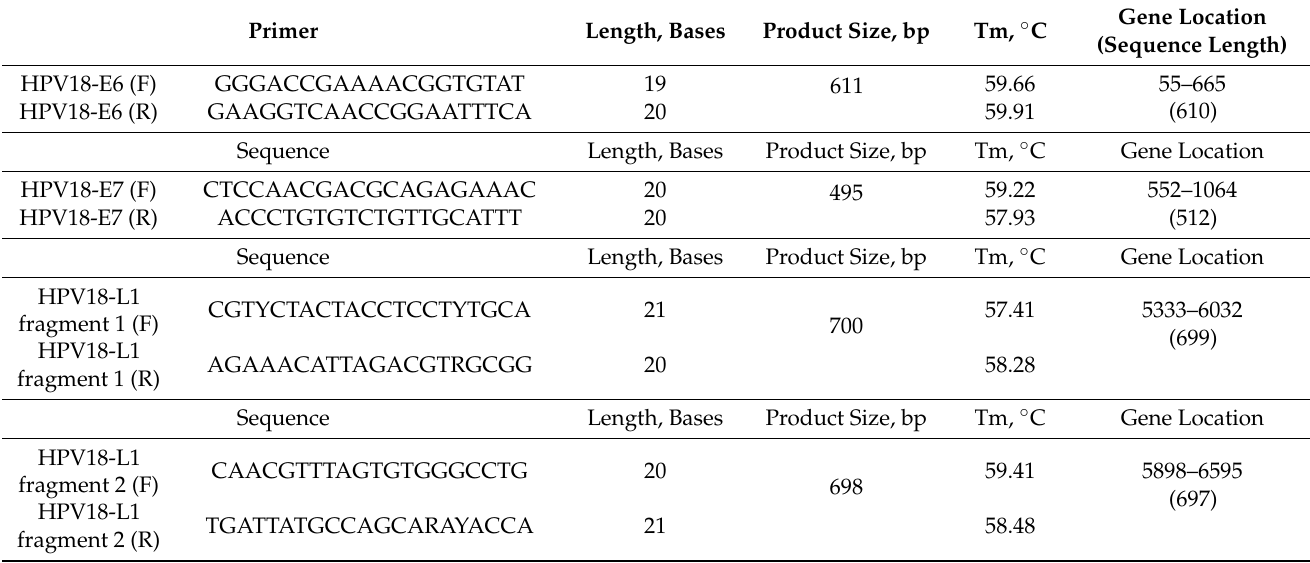
Table 4. In-house target-specific primers for HPV18 E6 and E7 and the multiple primer sets for